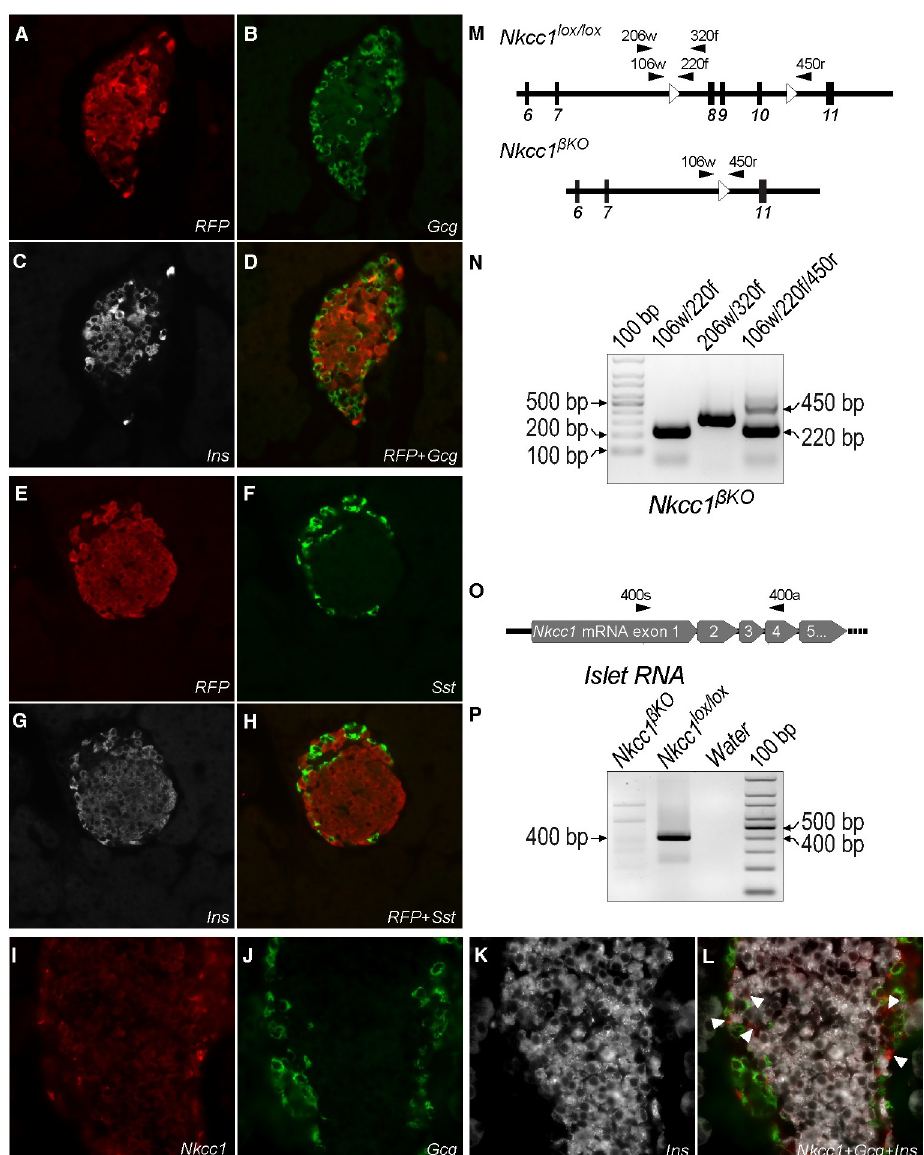
Fig 1. The Ins1 Cre line deletes target alleles exclusively in β -cells of the pancreatic islet. A-H . Representative pancreas sections of Ins1 Cre : Nkcc1 lox/lox : Tomato mice. Islets were coimmunolabeled against RFP (A and E), insulin ( Ins , C and G), glucagon ( Gcg , B) and somatostatin ( Sst , F) to identify β -, α - or δ -cells, respectively. Overlay images of A-C and E-G are shown in D and H, respectively. I-L . Representative pancreas sections of Nkcc1 β KO mice coimmunolabeled against Nkcc1 (I), Gcg (J) and Ins (K) showing β -cell-specific Nkcc1 deletion in the overlay image (L). Arrowheads in L indicate Nkcc1 immunoreactivity in Ins - or Gcg -negative cells. M . Shown are exons 6–11 (filled boxes) of the mouse Slc12a2 gene and Lox sites (empty arrowheads). Filled arrowheads indicate PCR primers 106w/220f and 206w/320f designed to amplify 5’ Lox sites as 220bp and 320bp bands, respectively. The primer triplet 106w/220f/450r co- amplifies 220bp and 450bp fragments corresponding to the Nkcc1 lox/lox genotype of non- β cells and Cre / Lox - recombined alleles of β -cells, respectively. N . PCR of islet genomic DNA from Nkcc1 β KO mice showing amplicons of expected sizes by using the primers indicated in M. O . Represented are exons 1–5 (filled arrows) of Nkcc1 mRNAs and the RT-PCR primer pair 400s/400a used to produce Nkcc1 amplicons of 400bp. P . Representative RT-PCR experiments using total islet RNA from Nkcc1 lox/lox and Nkcc1 β KO mice. Nkcc1 mRNA expression detected as amplicons of expected sizes mainly in Nkcc1 lox/lox samples.